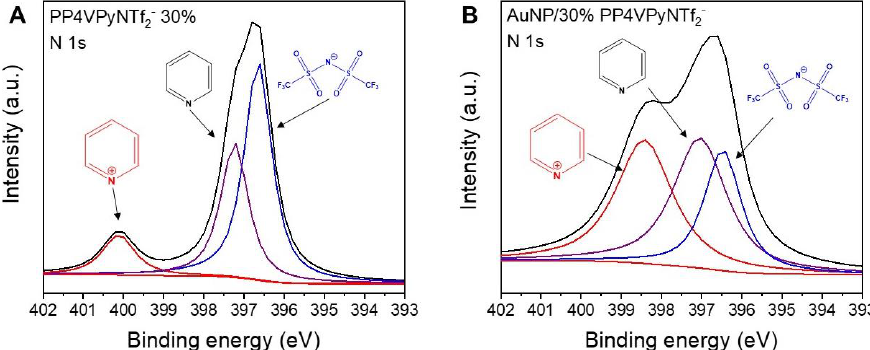
Figure 7. XPS deconvoluted peaks in the Nitrogen region of P4VPy/PP4VPyNTf 2 − (30%) nanofibers ( A ) before and ( B ) after the adsorption of gold ions. ( A ) before and ( B ) after the adsorption of gold